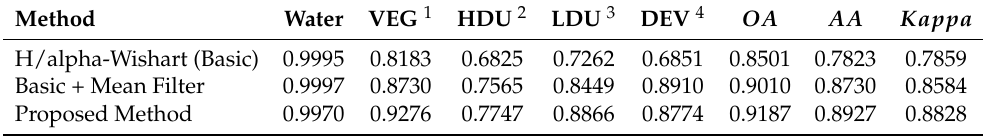
Figure 7. Confusion matrix of H/alpha-Wishart method and VQC-CAE model. The categories from the first row to the fifth row are water, vegetation, high-density urban, low-density urban and developed. The blue gradient arrow represents the difference of confusion matrix element values from 0 to 10 6 ; the larger the matrix element value, the darker the color. The larger the value of the non-diagonal element in the confusion matrix, the easier it is to classify pixels from other categories into this category. The larger the diagonal element, the smaller the misclassification of the category. Table 2. Comparison of the classification accuracy of our approach with other methods.